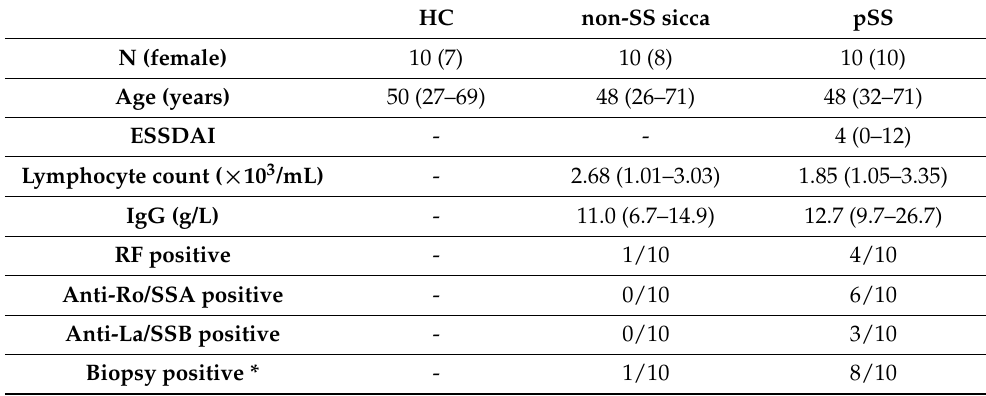
Table 2. Characteristics of patient group